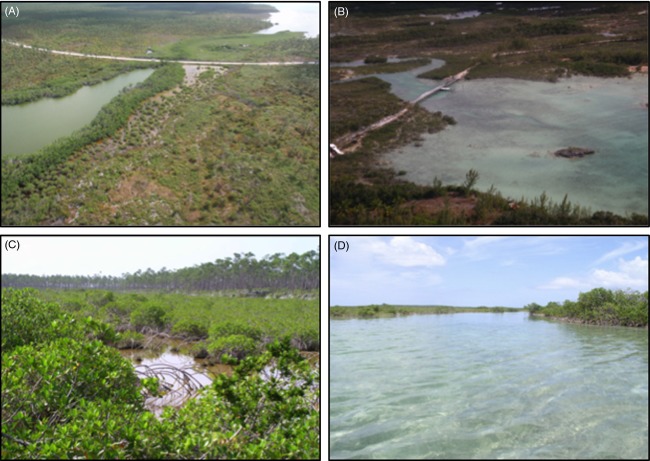
Representative aerial photographs of (A) fragmented, (B) unfragmented, and ground-level photographs of (C) fragmented and (D) unfragmented Bahamian tidal creeks. The road crossing in (A) severely restricts hydrological connectivity, while the bridge in (B) provides minimal to no restriction of water flow.